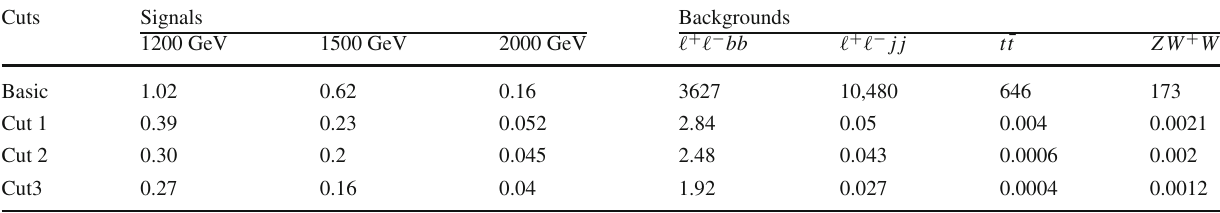
Fig. 3 Normalized distributions for the signals (with m B =1200, 1500 and 2000 GeV) and SM backgrounds at the CLIC Table 1 Cut flow of the cross sections (in ab) for the signals and SM backgrounds at the 3 TeV CLIC with g ∗ = 0 . 1 and three typical VLQ- B quark